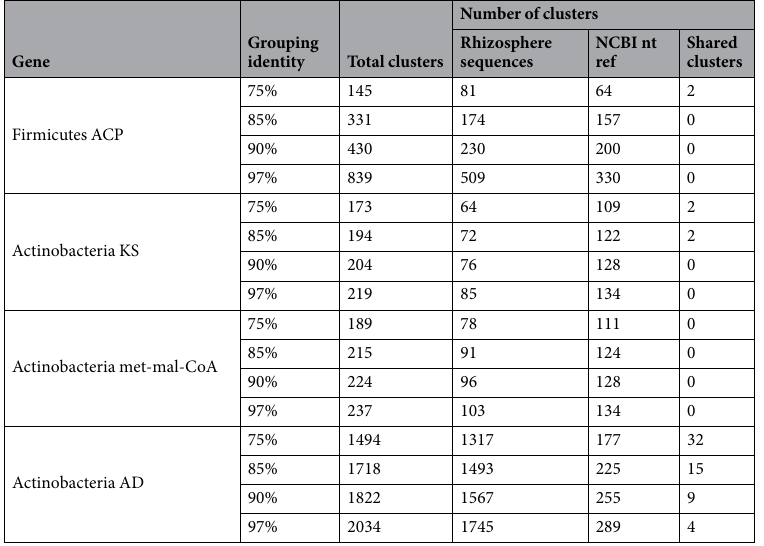
Table 1. Number of clusters found when rhizosphere sequences obtained in this study and NCBI nt sequences were grouped at different levels, ranging from 75% to 97% sequence